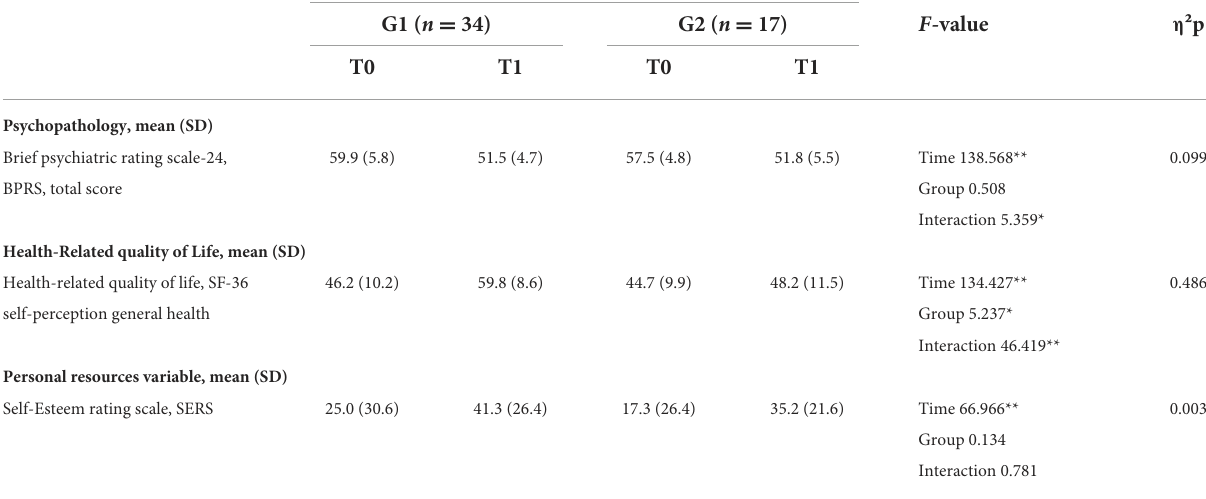
TABLE 5 Psychopathological, health-related quality of life, and personal resources in G1 and G2 at T0 and